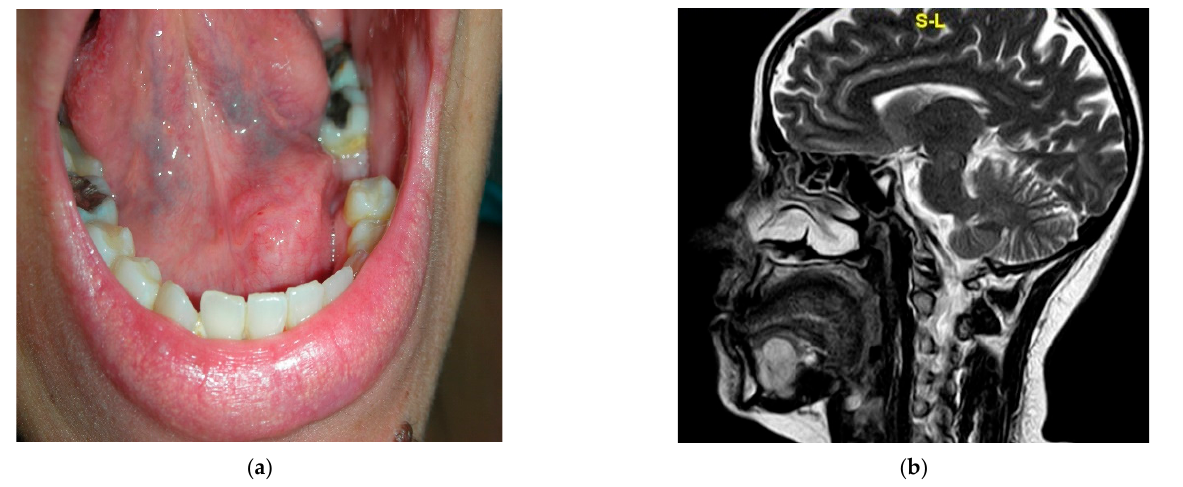
Figure 5. ( a ) Multiplanar MRI performed on the patient. ( b ) Preoperative images of our patient’s mass.